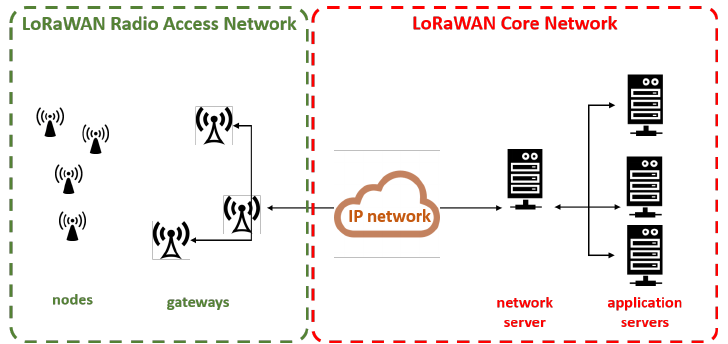
Figure 2. LoRaWAN network